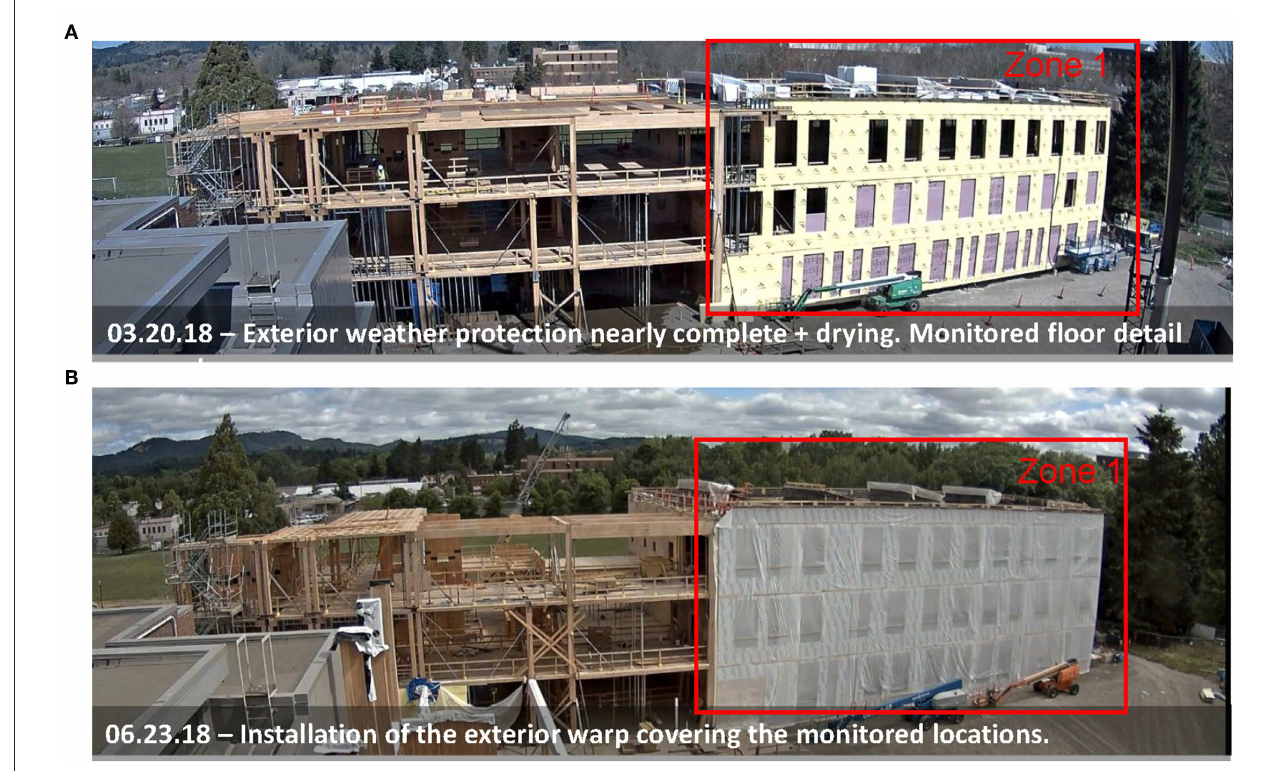
FIGURE 2 | Webcam images of the construction